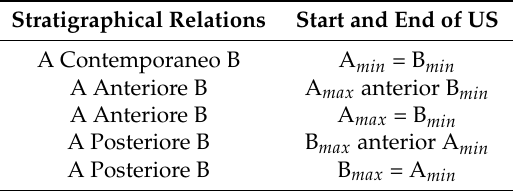
Table 2. Harris relations seen from an interval point of